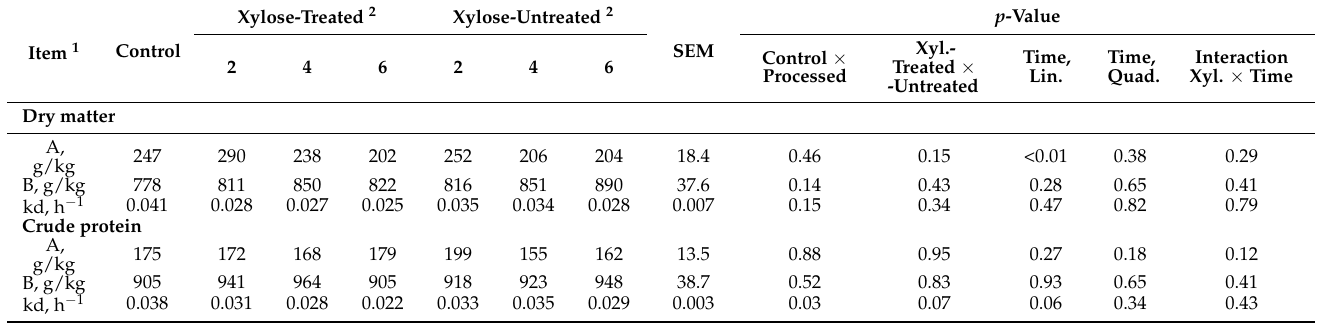
Table 6. Effects of microwave oven heating and xylose inclusion on the rumen degradation parameters of peanut meal.